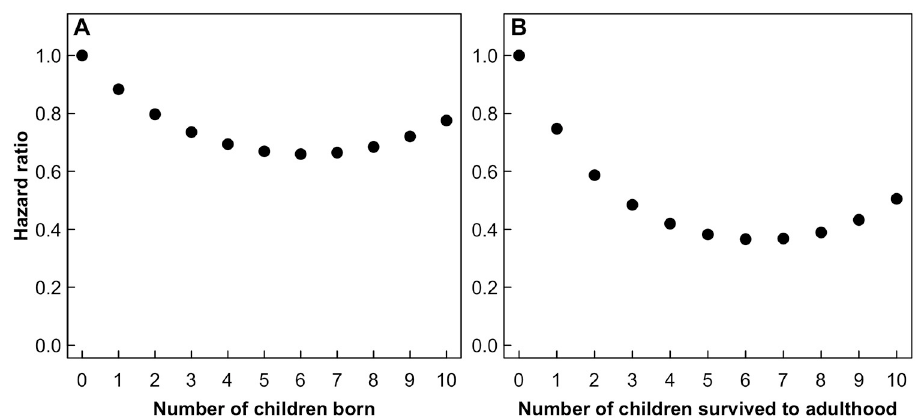
Fig 2. Quadratic relationship between number of children and maternal mortality risk. The predicted values of hazard from the model across the range of the data. (a) quadratic relationship between number of children born and maternal mortality risk (Hypothesis 2); (b) quadratic relationship between number of children survived to 15 years of age and maternal mortality risk (Hypothesis 2).